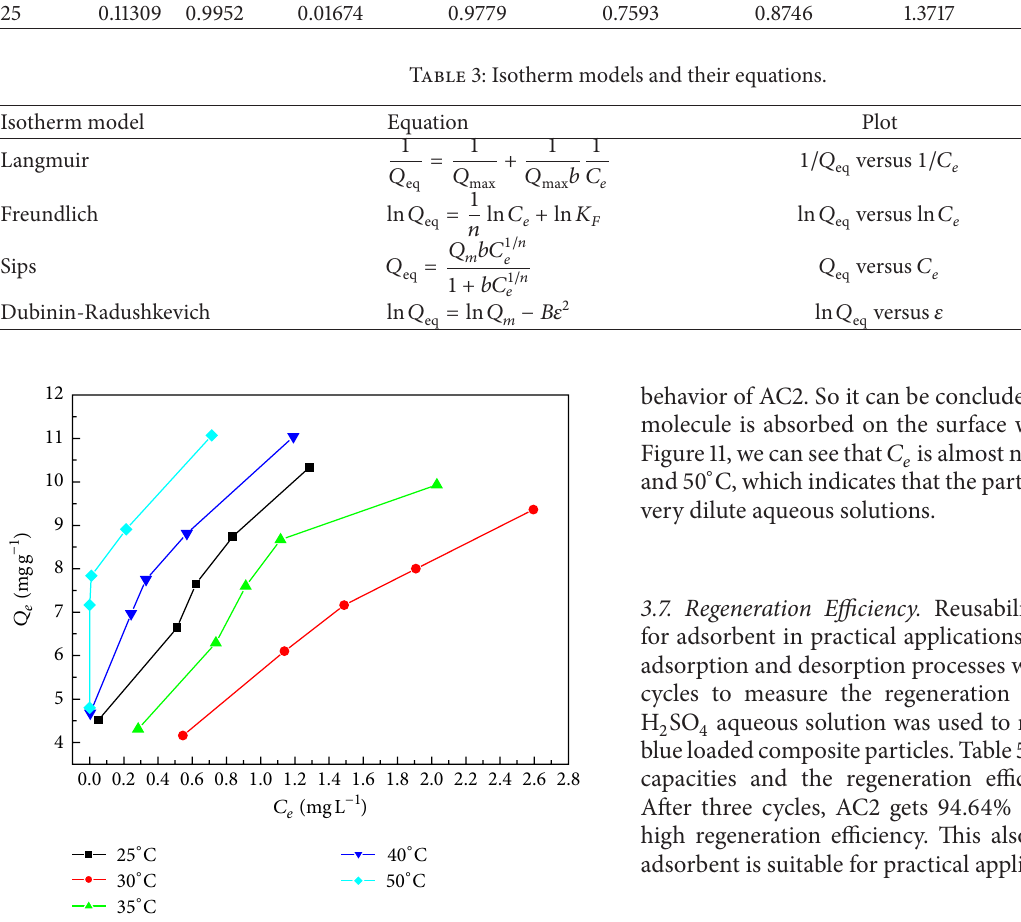
Figure 11: The curve of 𝐶 𝑒 - 𝑄 𝑒 of AC2 under different temperatures with duration time of 36